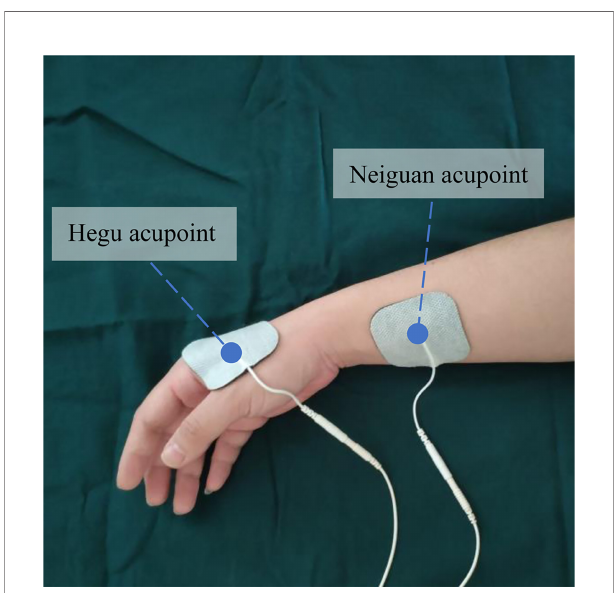
FIGURE 1 | Location diagram of the Hegu and Neiguan